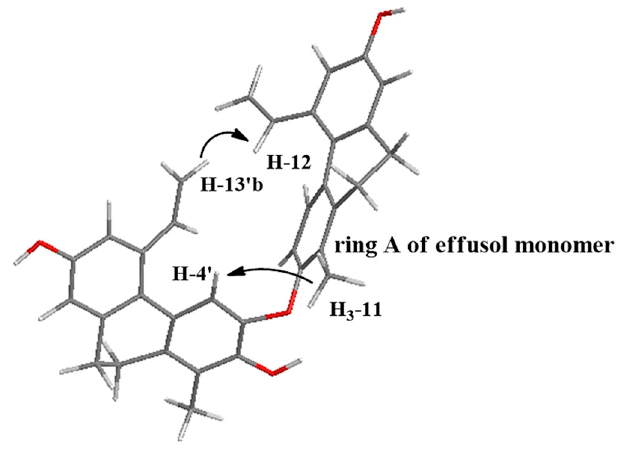
Figure 3. Calculated molecular structure of maritin D ( 4 ). The arrows indicate diagnostic NOESY correlations. Note that the markedly upfield shifted H-4 ′ and H-12 ′ –H 2 -13 ′ are situated in the shielding cone of ring A.